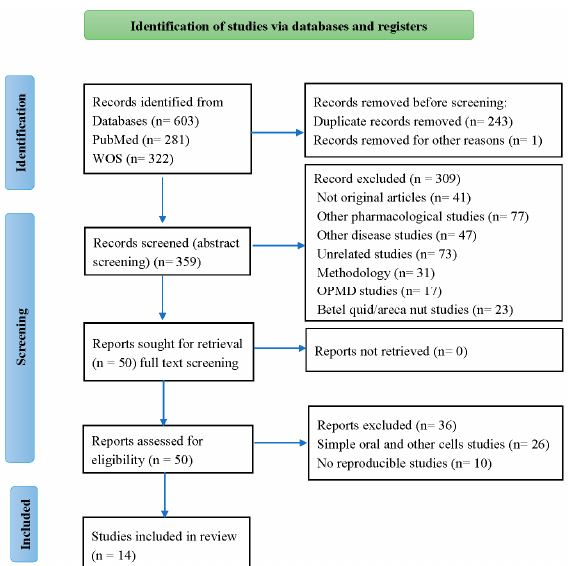
Figure 1. Systematic review fl owchart. Finally, evidence, explanations, and comments are provided on the basis of all 14 articles. on the basis of all 14